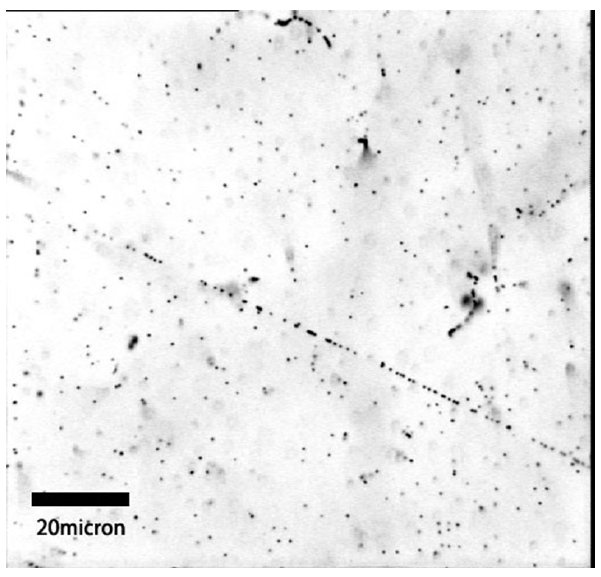
Fig. 2. Microscopic image of developed nuclear emulsion